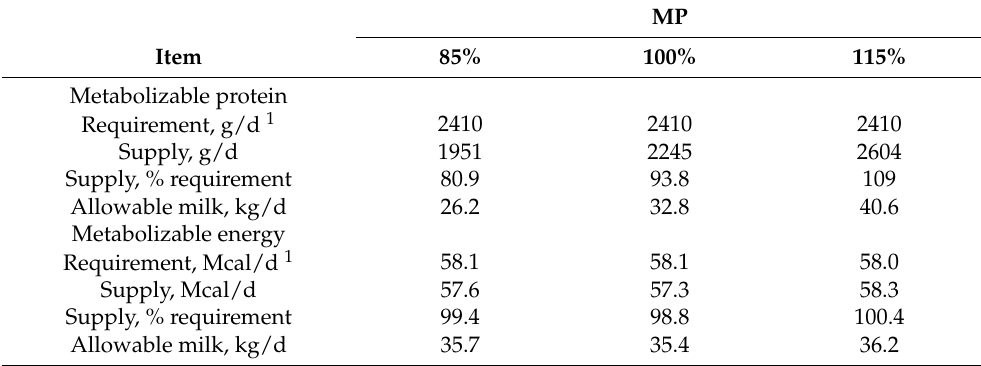
Table 9. Prediction of metabolizable protein and metabolizable energy in Ayrshire cows using the experimental diets formulated to Holstein